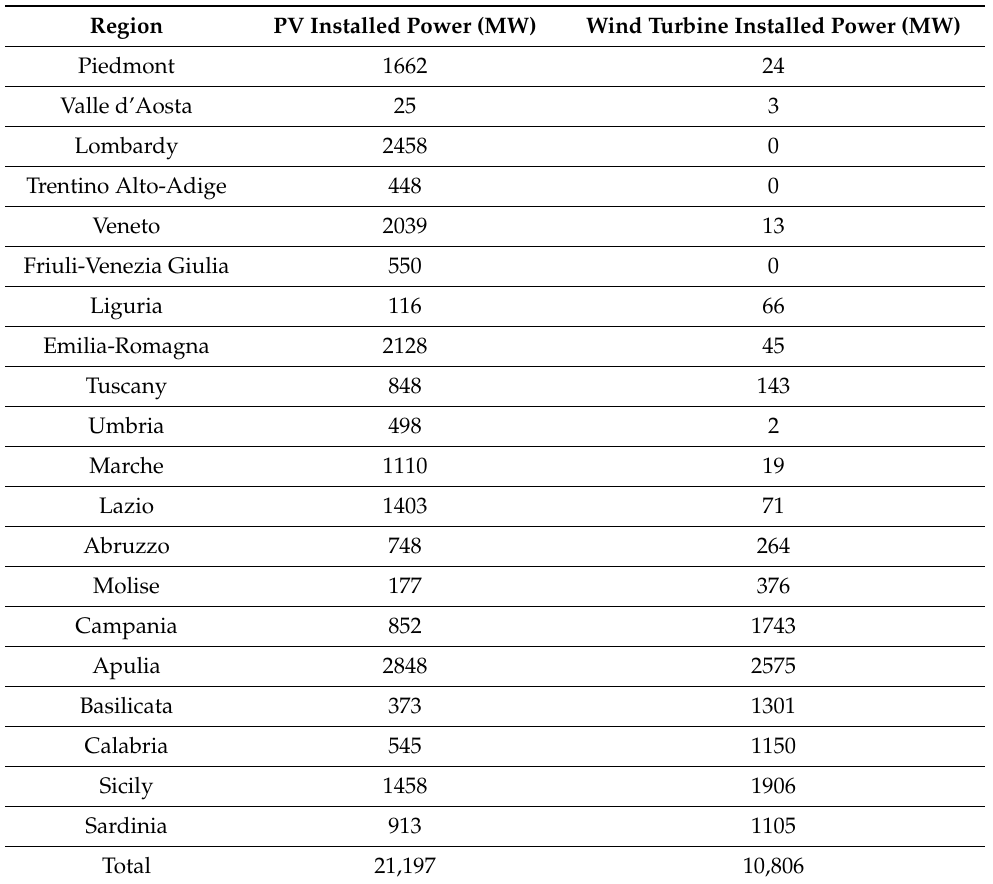
Table 1. Current installed power capacity of photovoltaic (PV) and wind turbine powerplants in Italy by Regions (data updated to June 2020, from